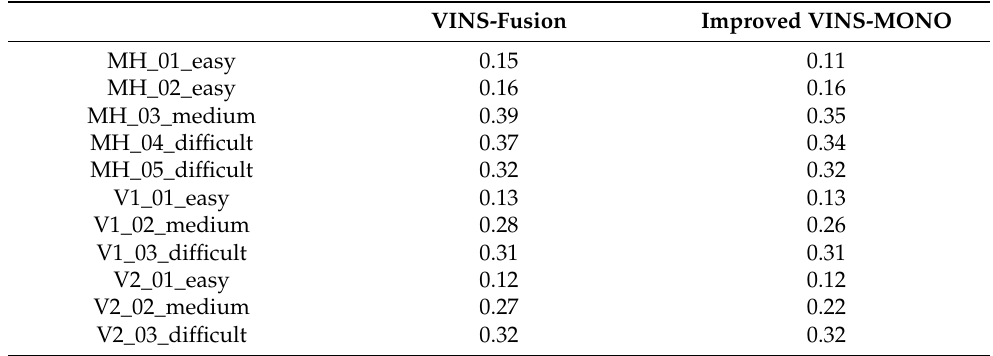
Table 2. The absolute pose error of VINS-Fusion algorithm is compared with that of the improved algorithm in the EuRoC dataset. (Unit: meter).